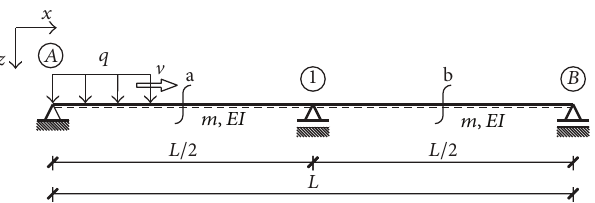
Figure 10: Two-span continuous uniform beam loaded with moving distributed load.